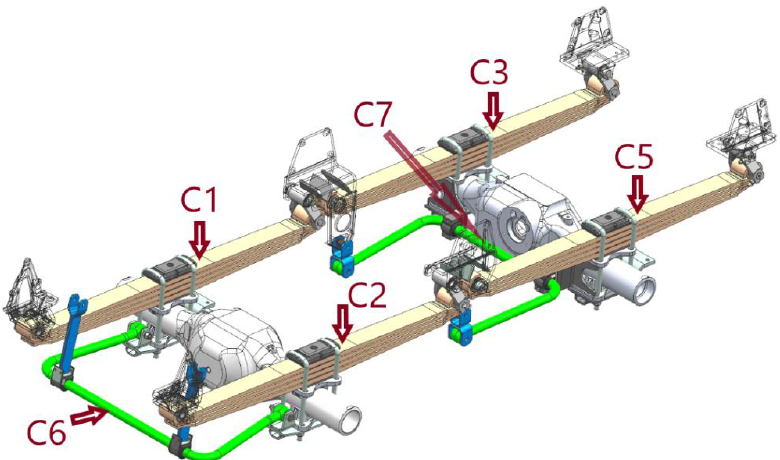
Figure 4. Measurement points on the elements of the suspension system of the first and second axles. For strain measurements, inverted HBR strain gauge half-bridges with a strain